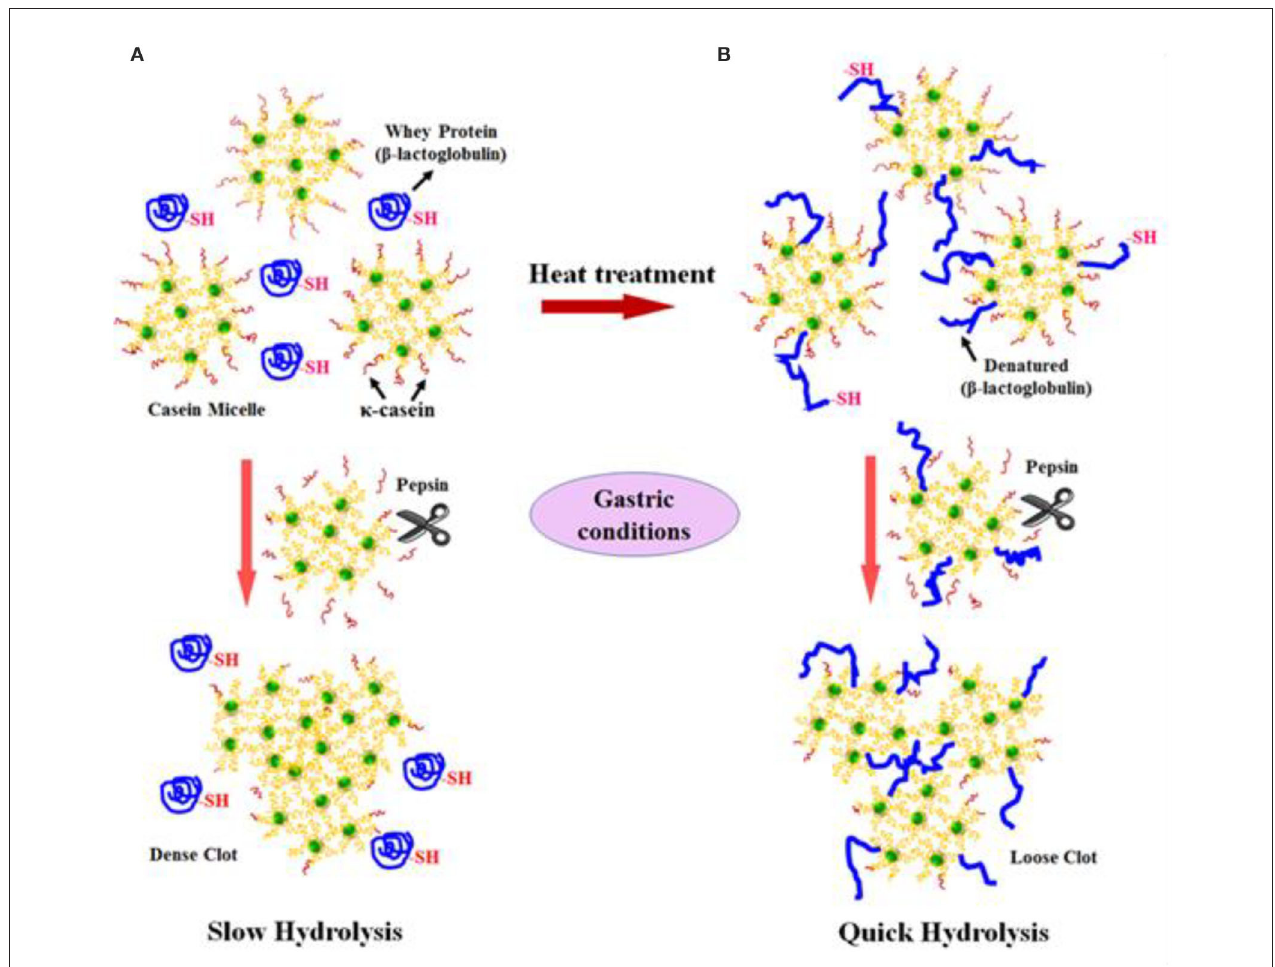
FIGURE 3 | Schematic diagram of the possible mechanism of events during the formation of protein curds from (A) raw milk (unheated) and (B) heated milk during gastric digestion. Source: Adapted from Ye et al. ( 145).